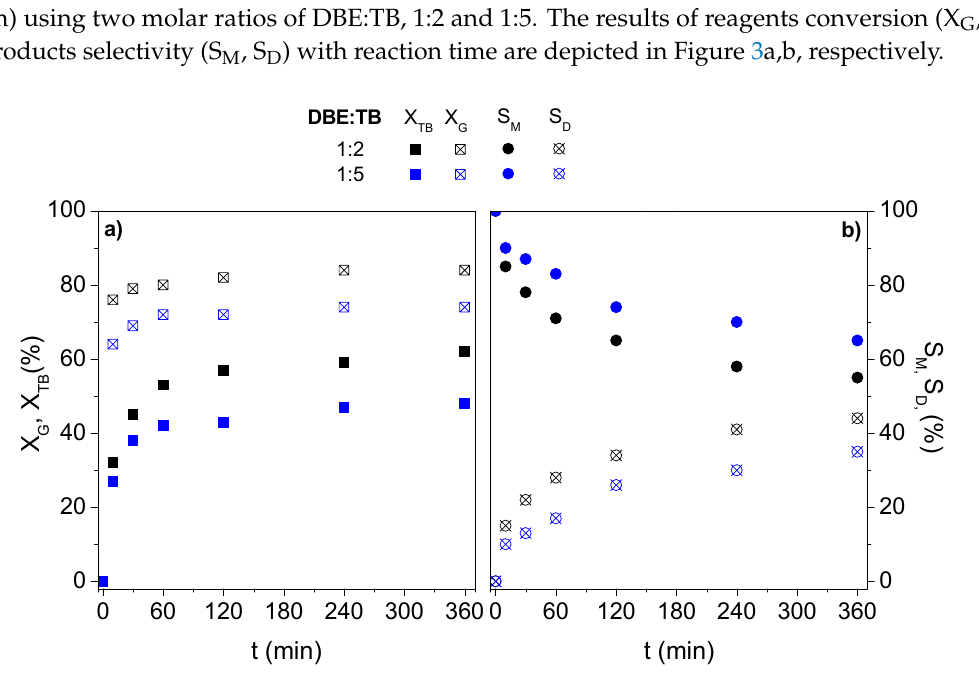
Figure 3. Influence of DBE concentration on G and TB conversion ( a ) and M and D selectivity ( b ) with reaction time. Operating conditions: 70 °C, 4 bar, G:TB = 1:3, C cat = 20% (runs R1 and R2 of Table 3).